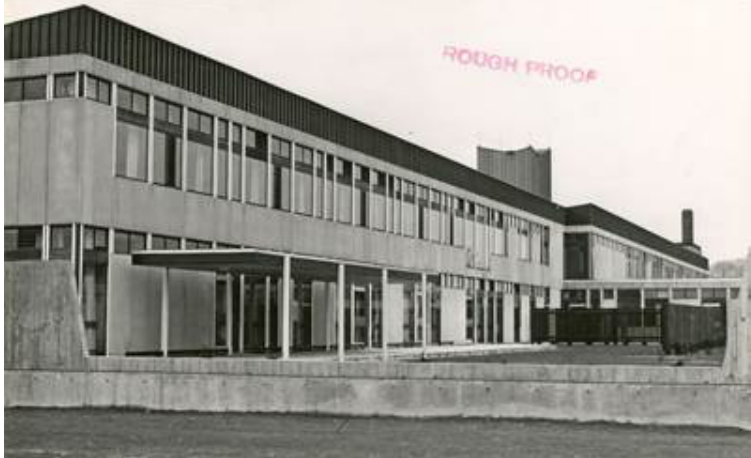
Figure 2. Post-war Admission Villa, Fulbourn Hospital, Cambridgeshire, front elevation, 1964 (Source: ‘Photographs taken at the opening of Kent House by Princess Marina, Duchess of Kent, 1964’, KHF/6/1/15, Cambridgeshire Archive Services, Ely, Cambridgeshire,